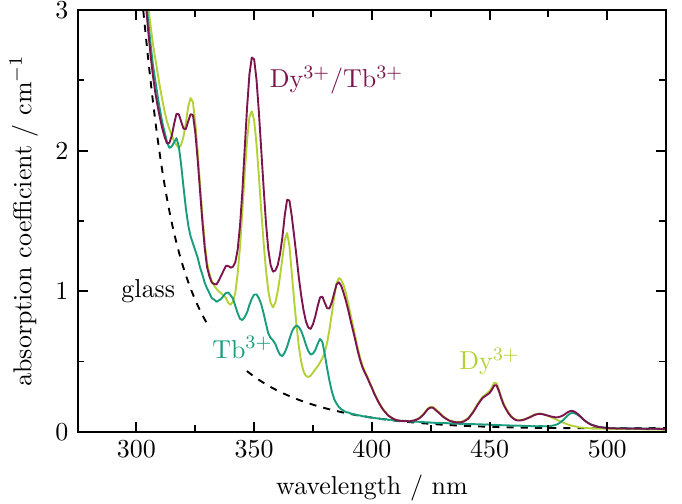
Figure 3. Absorption coefficients of Dy 3 + (0.45at.%) and Tb 3 + (0.90at.%) single-doped as well as Dy 3 + /Tb 3 + (0.45at.%/0.89at.%) double-doped BaB glasses. The glass background is indicated by the dashed line.